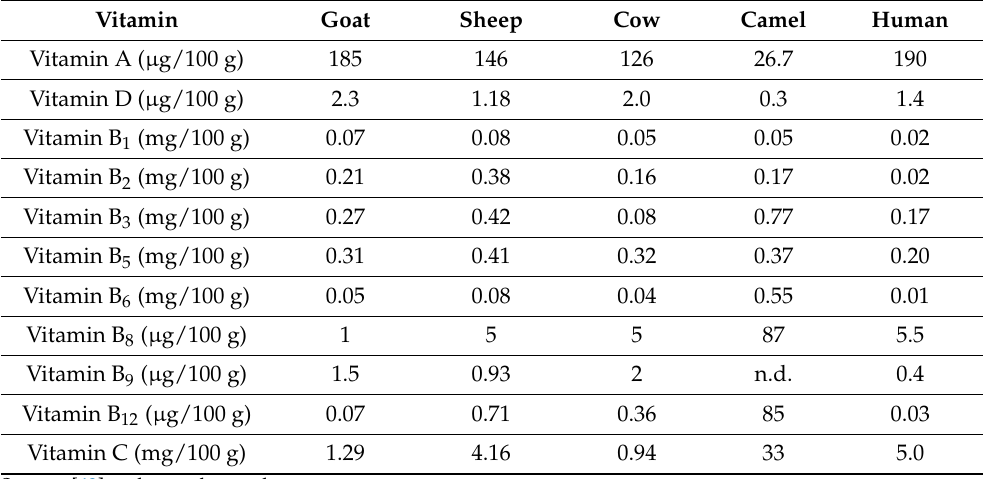
Table 6. Vitamin contents in milk from different mammalian species. Vitamin Goat Sheep Cow